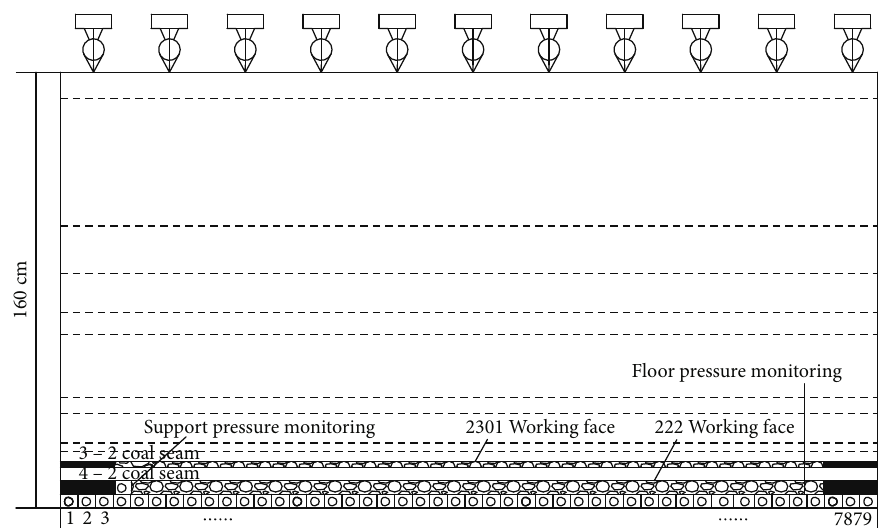
Figure 8: Design of similar simulation experiment model.